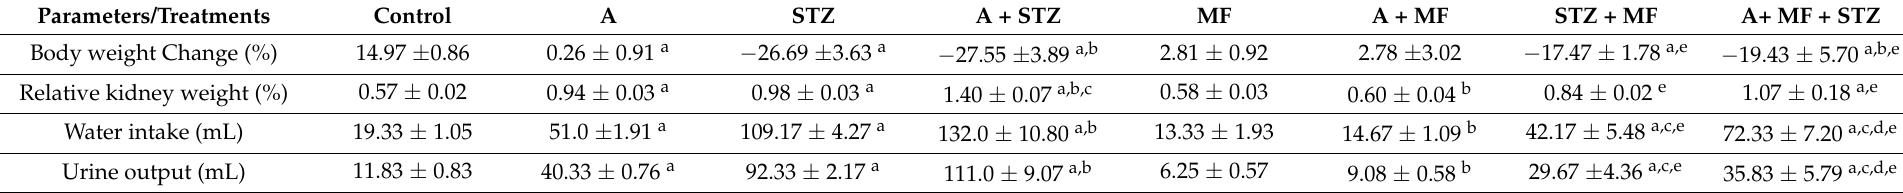
Table 1. Effect of metformin (MF) treatment on some physiological parameters in diabetic and non-diabetic rats with adenine (A)-induced chronic kidney disease (CKD). Parameters/Treatments